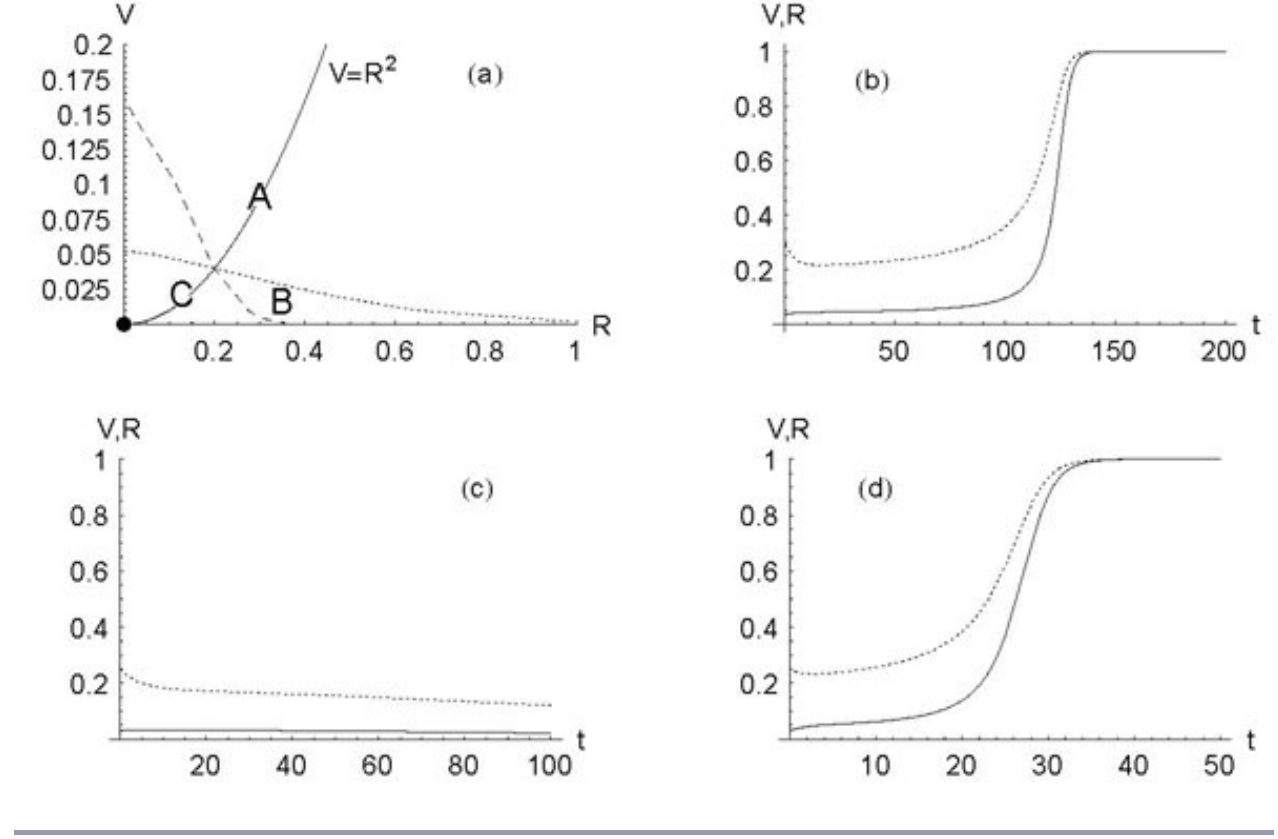
Fig. 1. (a) Basins of attraction of the two stable steady states, ( V , R )1 = (0,0) and ( V , R )3 = (1,1), for D ' 40, b ' = 0.9 and g ' = 0.15. The dotted line marks the transition between the two basins in the absence of spatial dynamics (i.e., D = 0), and the dashed line separates the two attraction domains when D 0 (D = 40); (b) temporal dynamics of V (solid line) and R (dotted line) with D 0 V = 0.035, R = 0.3. The other parameters are the same as in (a); (c) same as (b), but with R = 0.25; (d) same as (c) but with D = 0